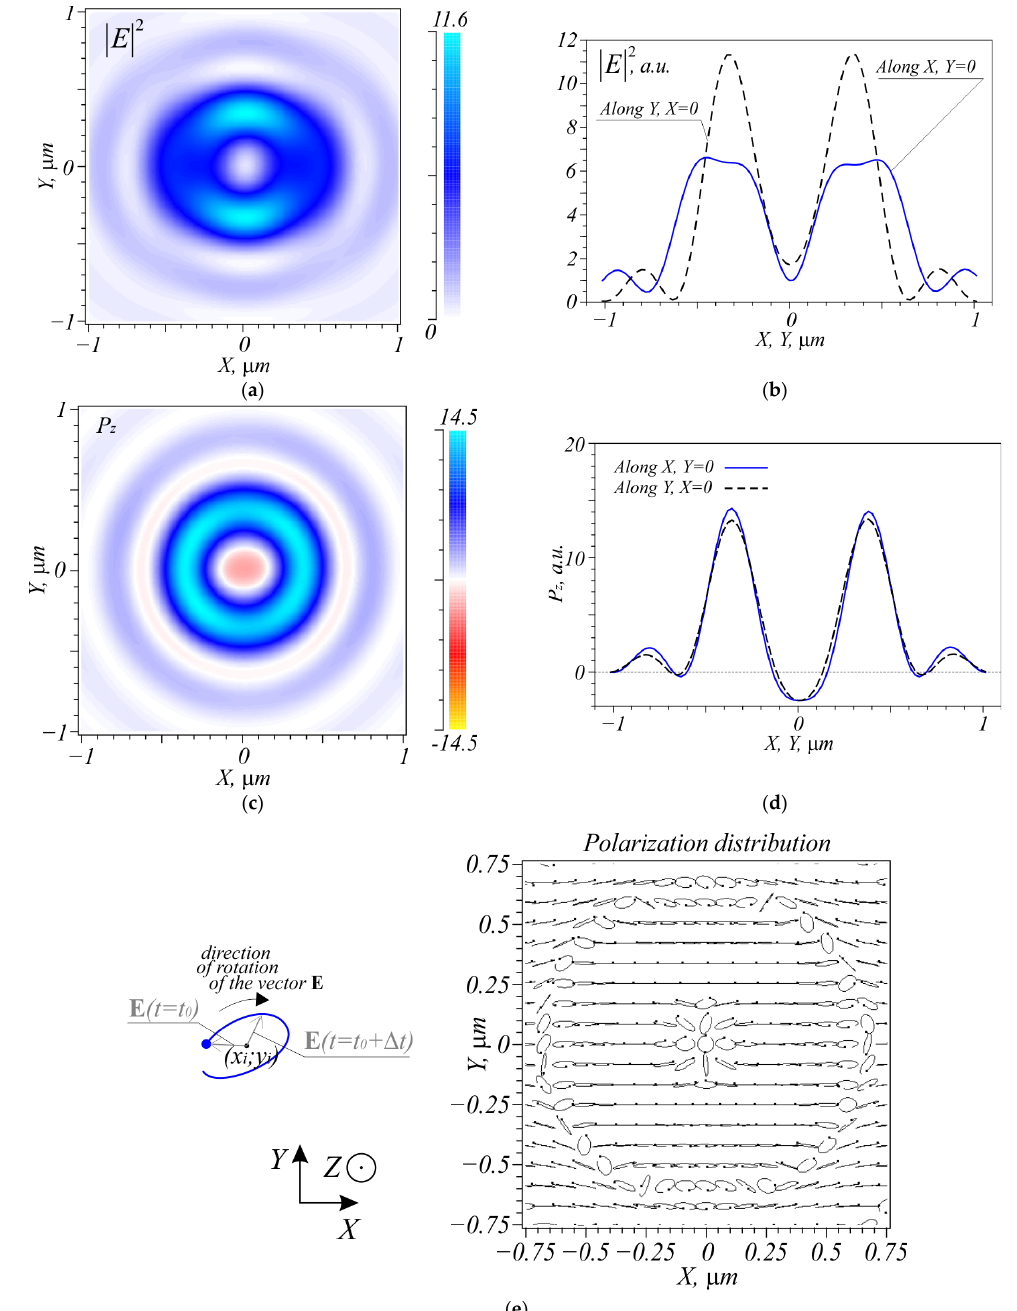
Figure 2. ( a ) The intensity; ( c ) the z -axis projection of the Poynting vector in the focus of a linearly polarized spherical wave containing a phase vortex with m = 2; ( b , d ) their respective profiles along the x - and y -axes and ( e ) polarization pattern in the focal plane at f = 1.31 µm. Ellipse-shaped curves in Figure 2e depict trajectories of the ends of the rotating polarization vectors with their origins found at the “ellipse center”. Bold dots mark the start of each single rotation period. The z -axis is directed towards the reader.